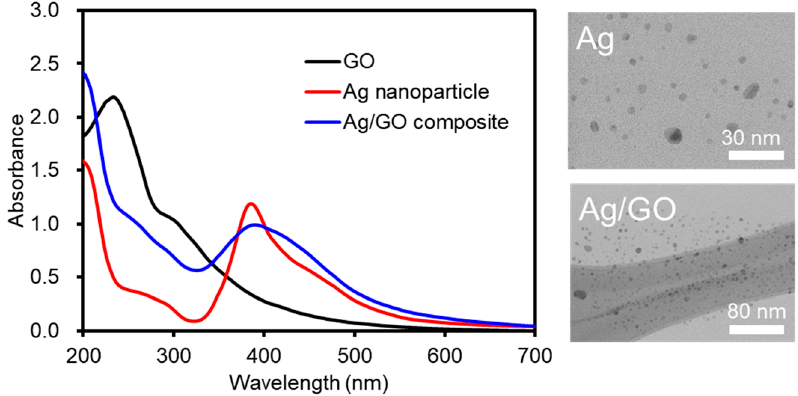
Figure 1. UV-vis spectra of synthesized nanoparticles and their presentative STEM images.